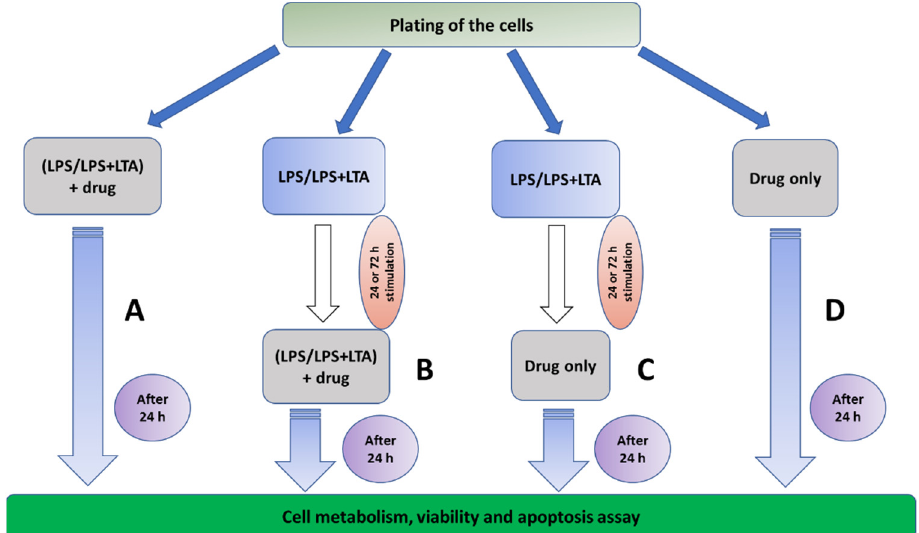
Figure 1. Clinical rationale of bacterial antigens and chemotherapeutic drug combination tests. ( A ) Plated cells were treated with different combinations of bacterial antigens and chemotherapeutic